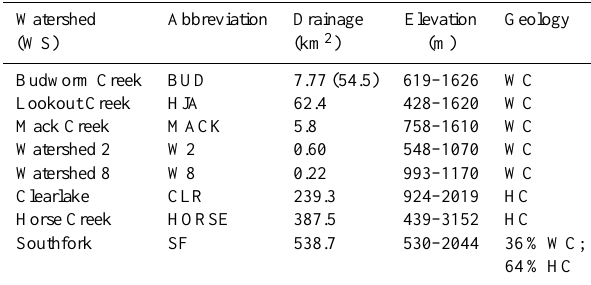
Table 1. Watershed characteristics.